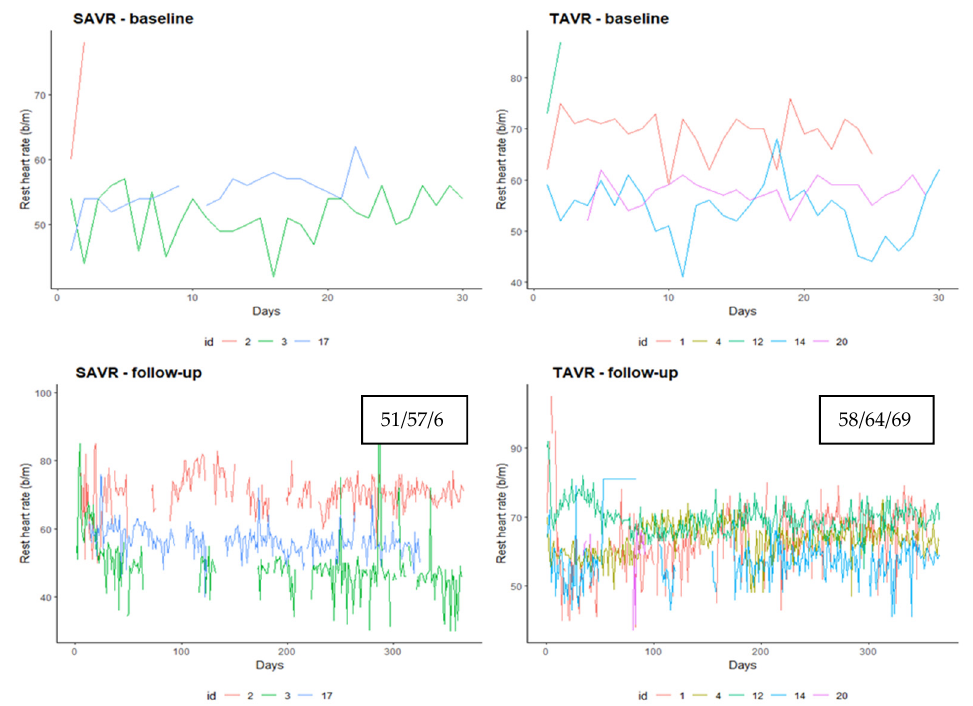
Figure 2. Rest heart rate trend recorded by the device according to procedure and baseline vs. follow-up period. Data in the box are the I, median and III quartile of rest heart